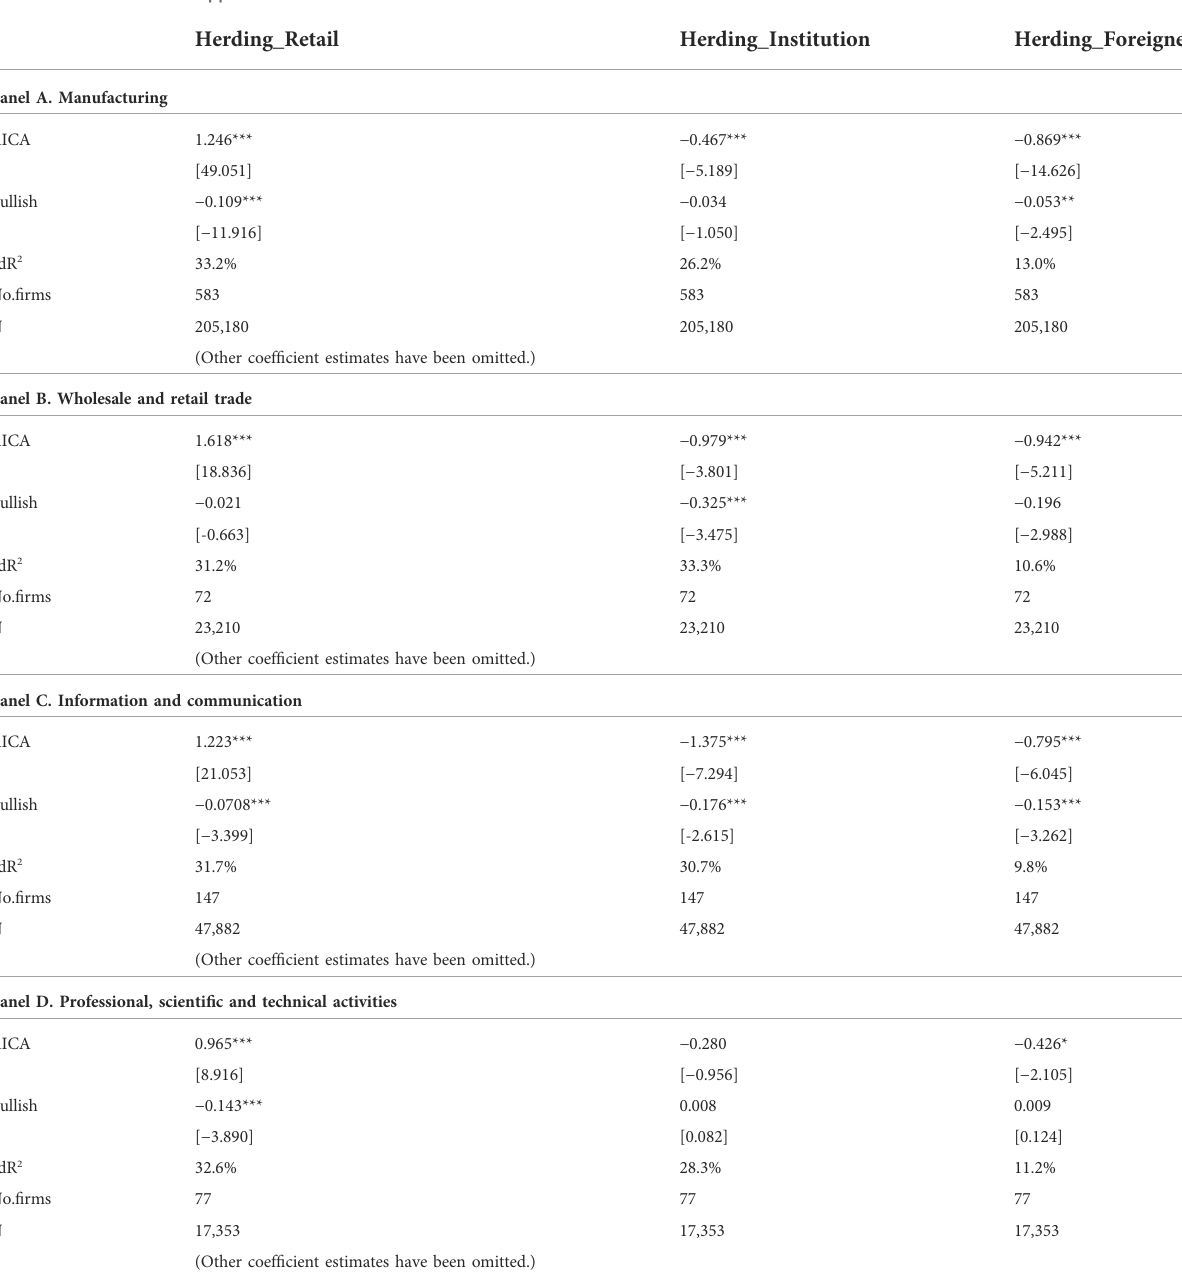
TABLE 7 Robustness tests of industry group. Table shows the coef fi cients of the results of regression analysis by industry are shown using Eq. 6 excluding industry fi xed effect. Panel A is Manufacturing industry, Panel B is Wholesale and retail trade industry, Panel C is Information and communication and Panel D is Professional, scienti fi c and technical activities industry. AICA is the abnormal ICA. Bullish is an investment sentiment indicator that represents the opinion score. For brevity, We only show the results of the main variables in the table and the coef fi cient estimates of controlled variables are